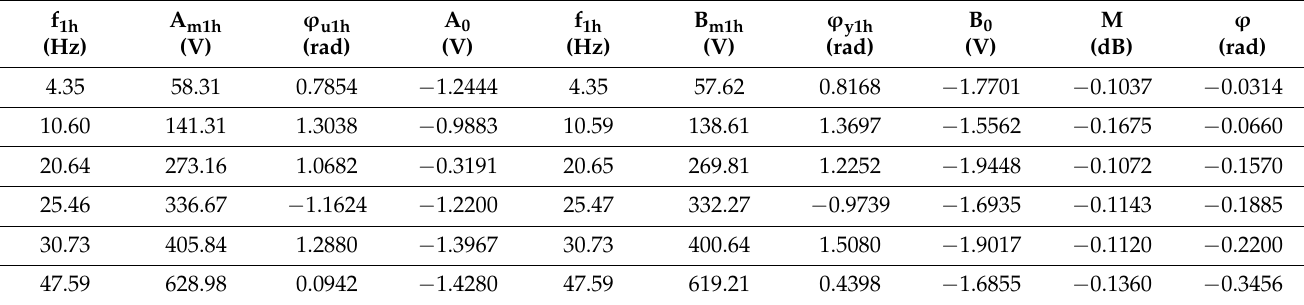
Table 1. Estimated parameters of the fundamental harmonic of the measurement signal of the voltage supplying the motor at the input and output of the analog filter and the values determined in accordance with the Formulas (4) and (5).